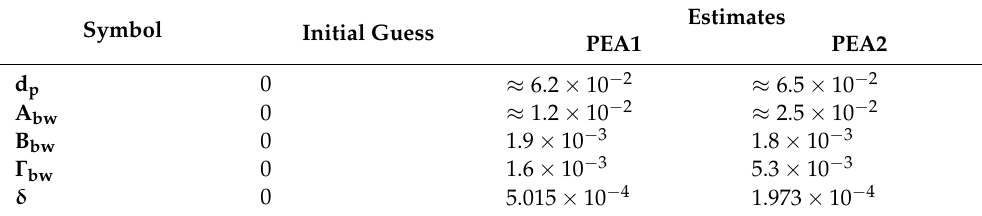
Figure A2. Parameter identification process for one of the PEAs and the corresponding hysteresis curve for both. Table A1. Estimation results of characteristic coefficients of the PEAs.